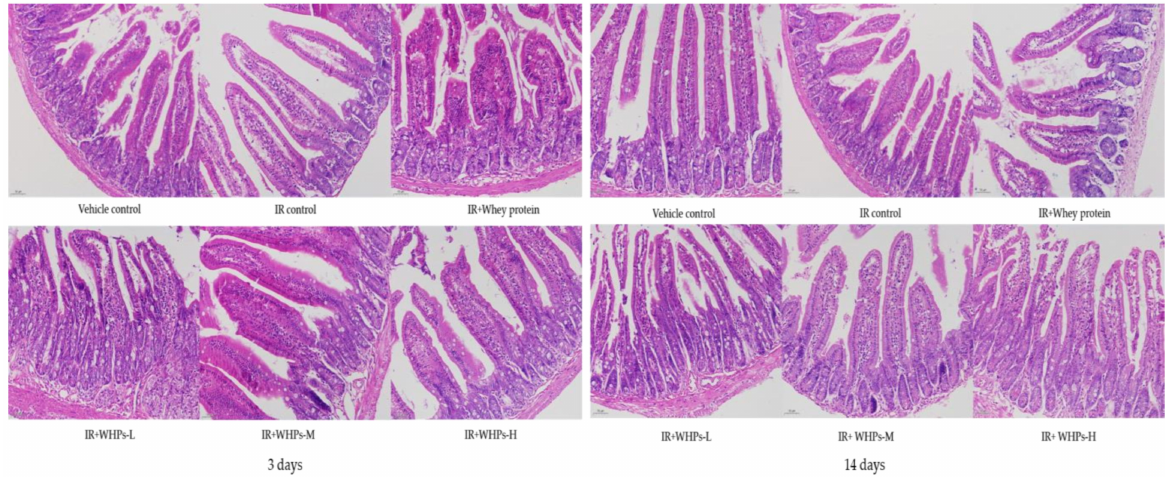
Figure 6. Effect of WHPs on intestinal morphology in irradiated mice (HE staining of sections, magnification: 200 × ). IR, irradiated mice; IR+WHPs-L, irradiated mice+low-dose whey hydrolysate peptides; IR+WHPs-M, irradiated mice+medium- dose whey hydrolysate peptides; IR+WHPs-H, irradiated mice+high-dose whey hydrolysate peptides. Table 9. Effect of WHPs on villus height and crypt depth in mice ( µ m, n = 8, x ± s). Group